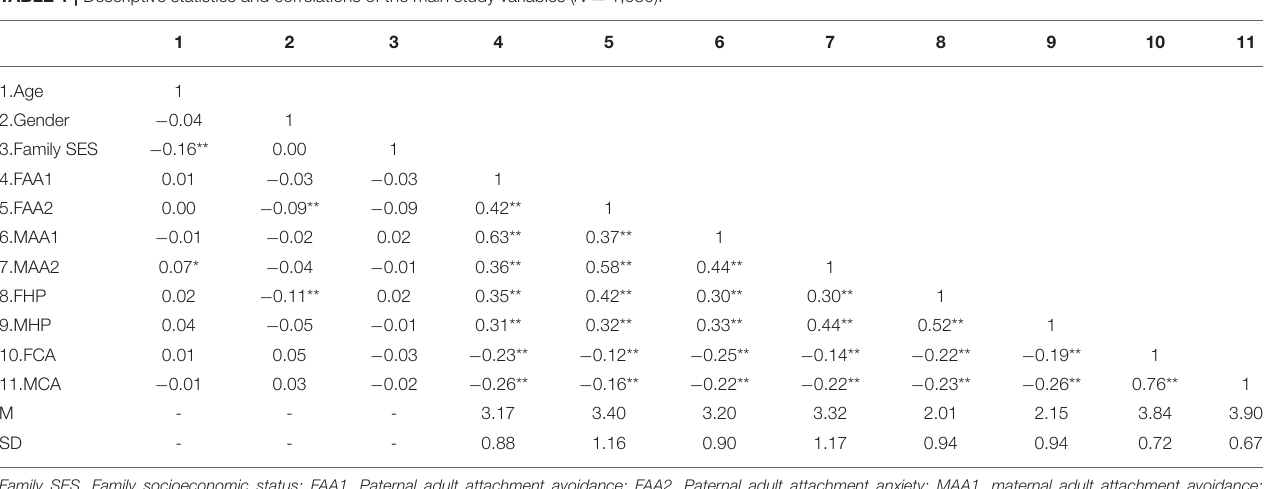
TABLE 1 | Descriptive statistics and correlations of the main study variables ( N = 1,030).